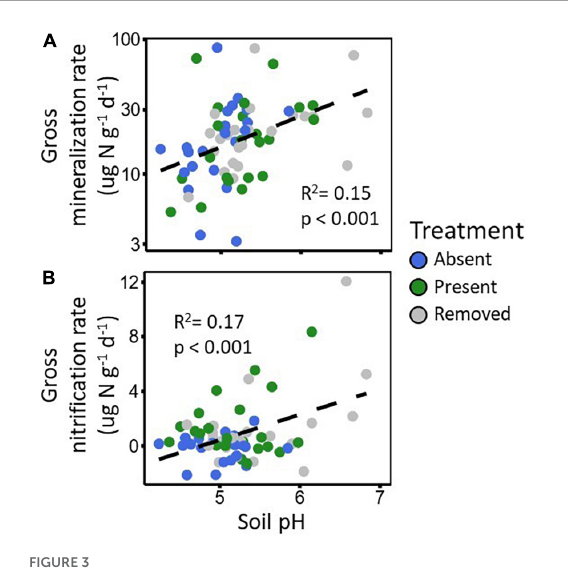
FIGURE3 Scatter plot depicting correlations between pH and N-cycling process rates for gross N mineralization (A) and gross nitrification (B) . Dashed lines represent the linear relationship as described by the R 2 and p -value within each